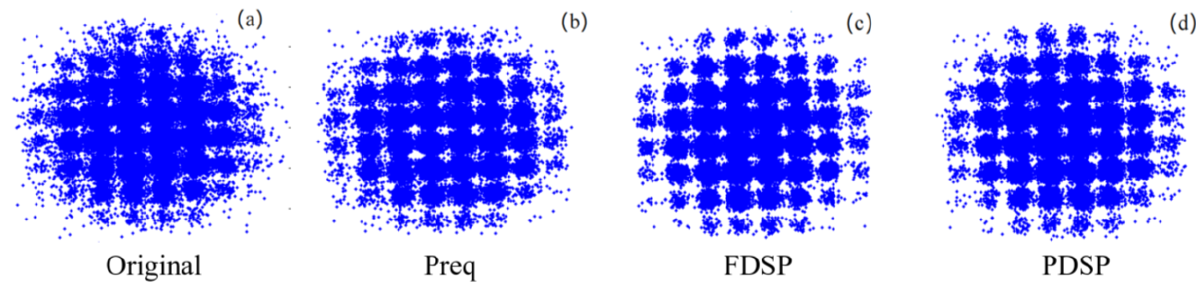
Figure 7. The estimated SC SNR for four kinds of received PS-DMT signals.